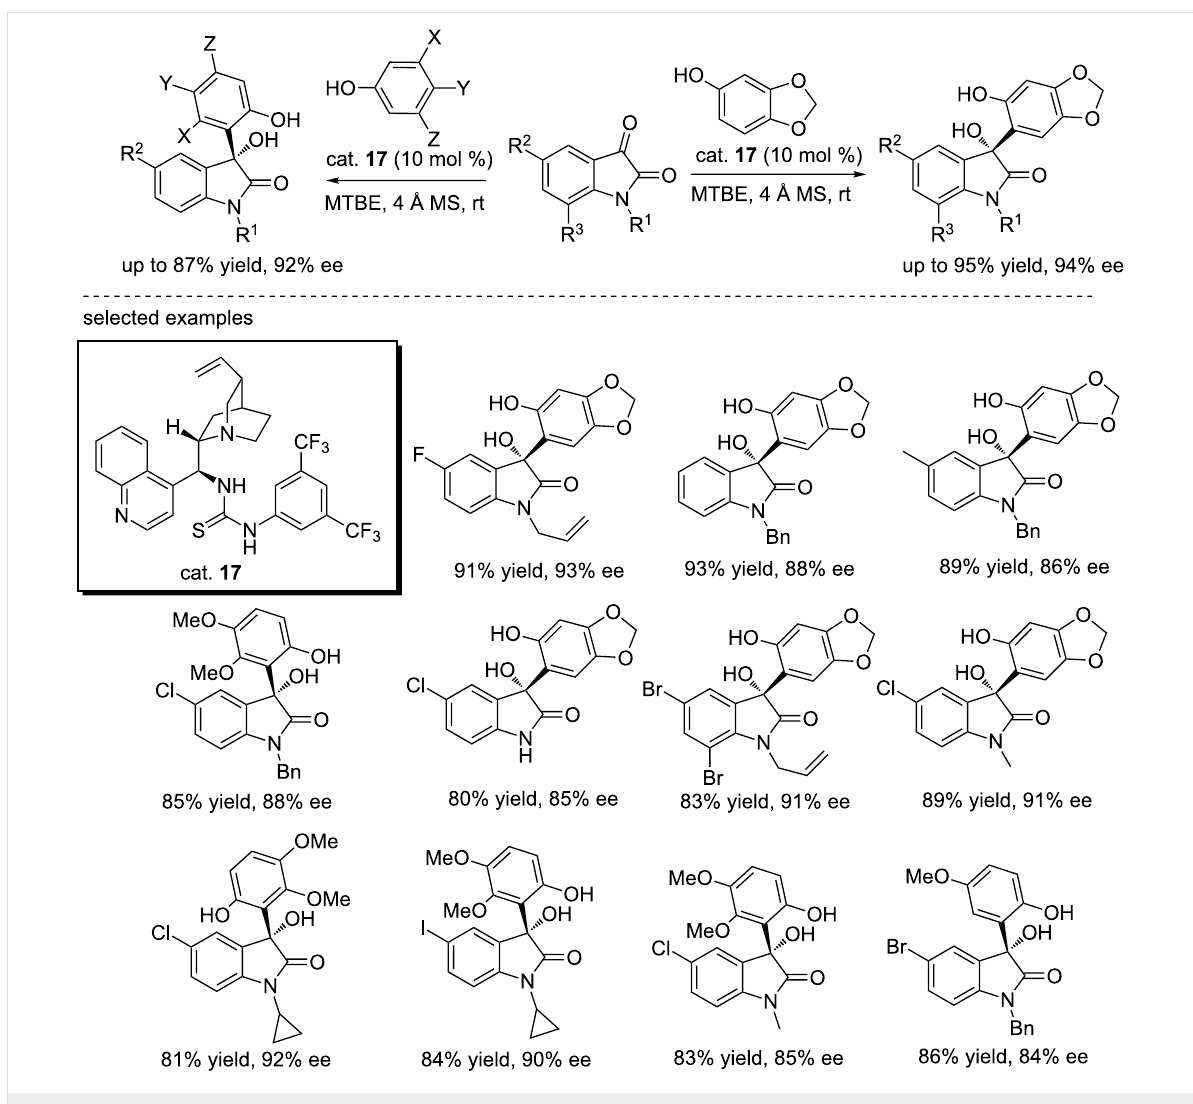
Scheme 31: Enantioselective Friedel-Crafts reaction of phenols with